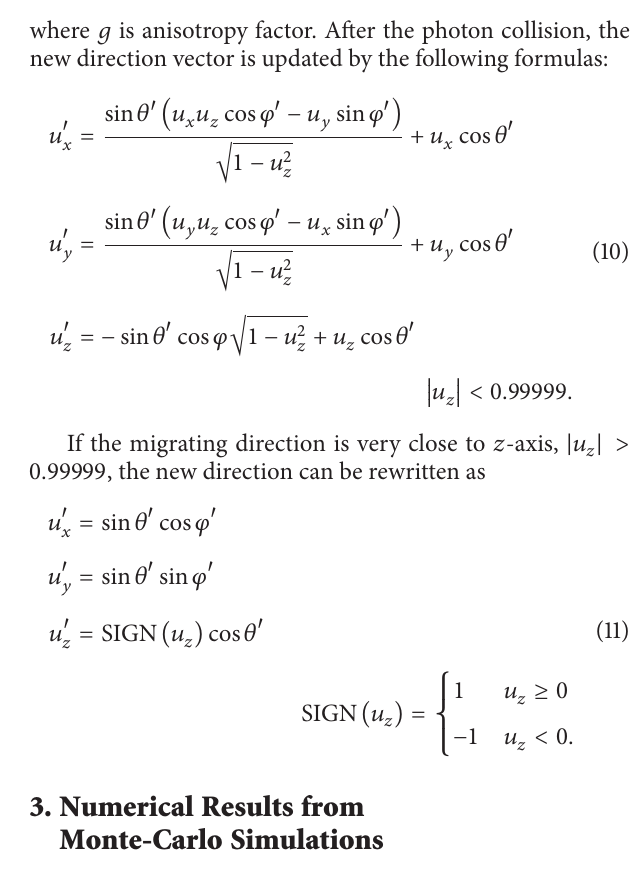
Figure 1: Schematic diagram for photons propagation model in stochastic rainfall.